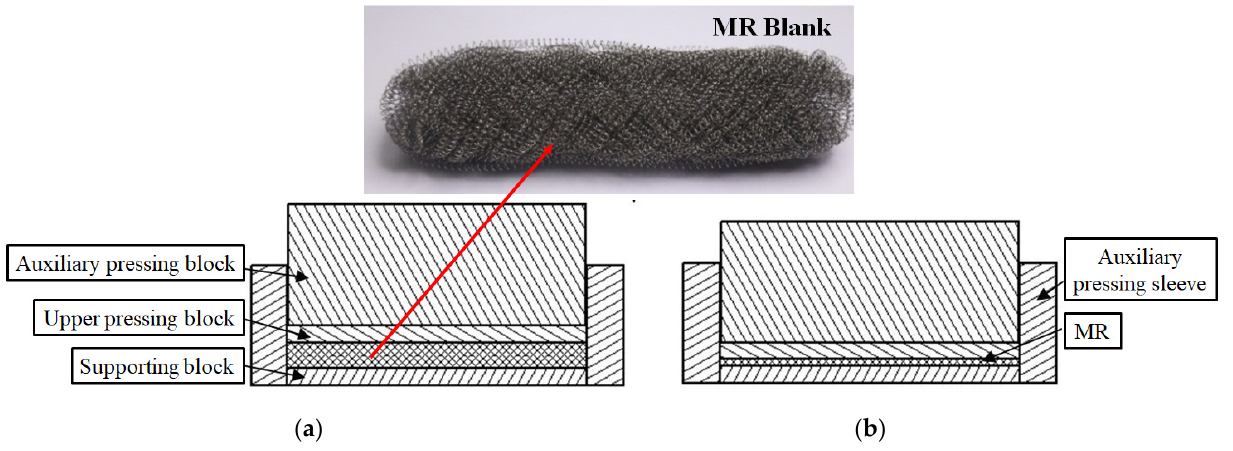
Figure 3. MR stamping forming drawing: ( a ) Initial stamping stage; ( b ) Press forming stage.